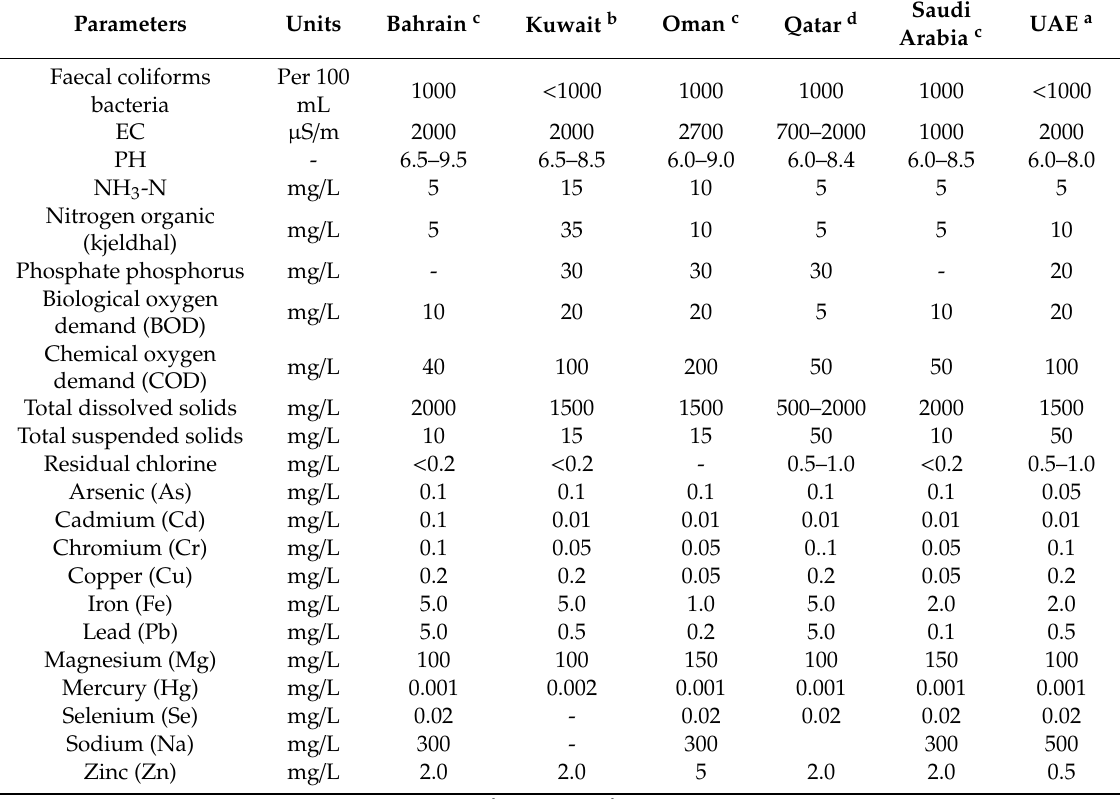
Table 4. Guidelines for wastewater reuse in agriculture in GCC